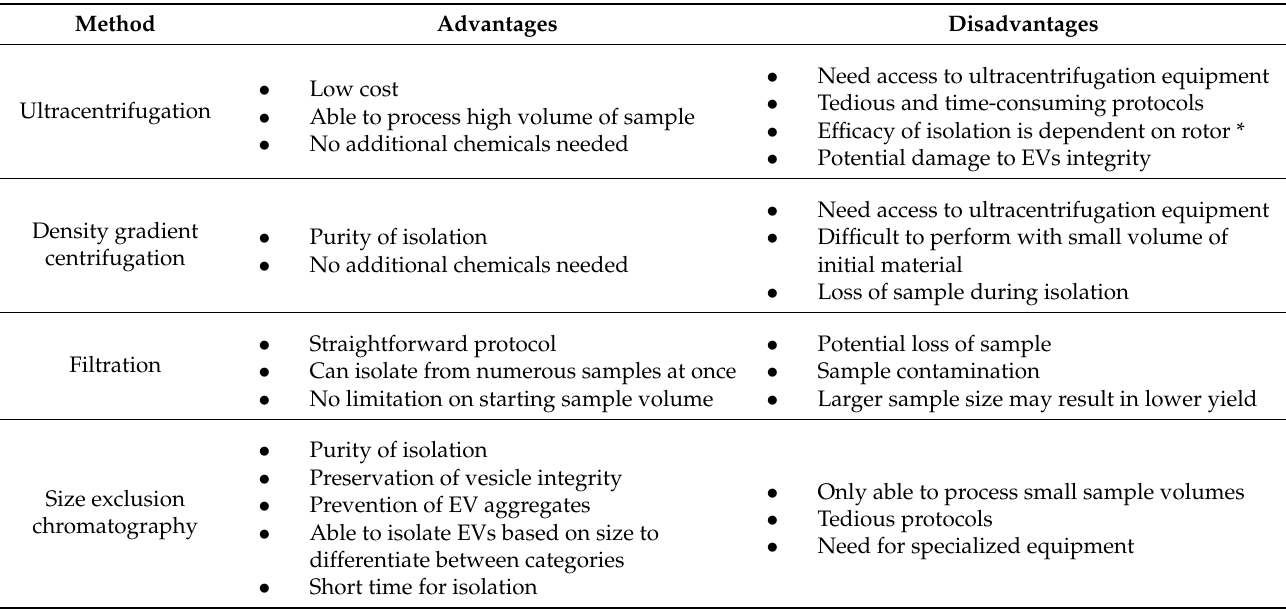
Table 2. Methods of EVs isolation. Advantages and disadvantages of some methods currently used to isolate EVs are listed. This table reflects and aims to summarize the findings of Gardiner et al., Carnino et al., and Brennan et al. [53–55]. For original detailed information, please refer to their